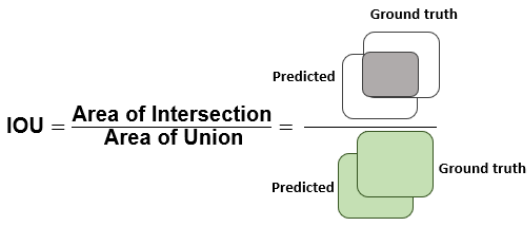
Figure 4. Pictorial description of IOU measure .